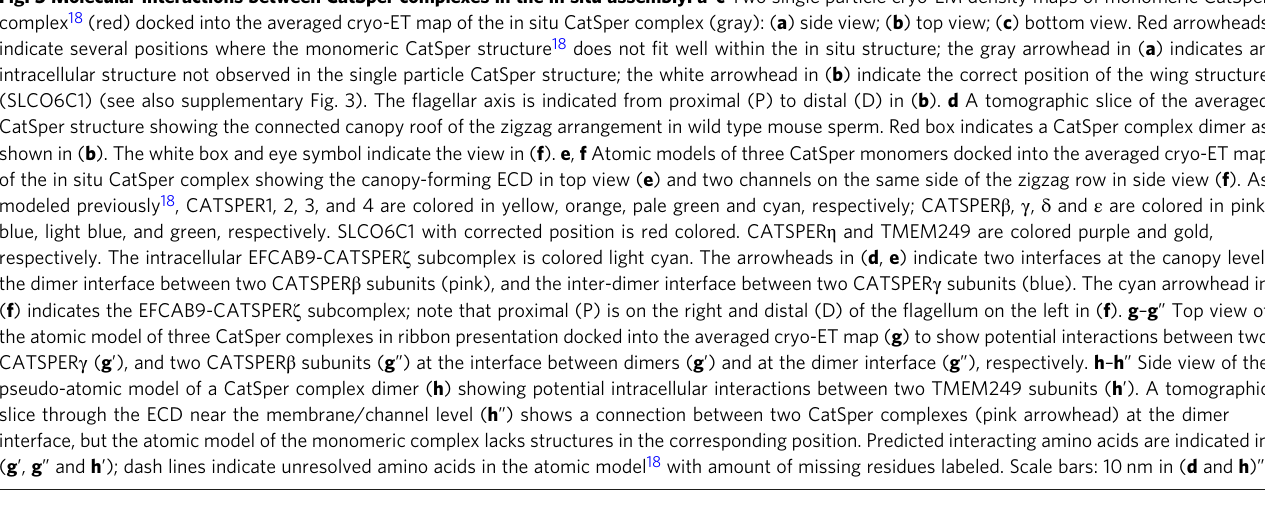
Fig. 5 Molecular interactions between CatSper complexes in the in situ assembly. a – c Two single particle cryo-EM density maps of monomeric CatSper complex 18 (red) docked into the averaged cryo-ET map of the in situ CatSper complex (gray): ( a ) side view; ( b ) top view; ( c ) bottom view. Red arrowheads indicate several positions where the monomeric CatSper structure 18 does not fi t well within the in situ structure; the gray arrowhead in ( a ) indicates an intracellular structure not observed in the single particle CatSper structure; the white arrowhead in ( b ) indicate the correct position of the wing structure (SLCO6C1) (see also supplementary Fig. 3). The fl agellar axis is indicated from proximal (P) to distal (D) in ( b ). d A tomographic slice of the averaged CatSper structure showing the connected canopy roof of the zigzag arrangement in wild type mouse sperm. Red box indicates a CatSper complex dimer as shown in ( b ). The white box and eye symbol indicate the view in ( f ). e , f Atomic models of three CatSper monomers docked into the averaged cryo-ET map of the in situ CatSper complex showing the canopy-forming ECD in top view ( e ) and two channels on the same side of the zigzag row in side view ( f ). As modeled previously 18 , CATSPER1, 2, 3, and 4 are colored in yellow, orange, pale green and cyan, respectively; CATSPER β , γ , δ and ε are colored in pink, blue, light blue, and green, respectively. SLCO6C1 with corrected position is red colored. CATSPER η and TMEM249 are colored purple and gold, respectively. The intracellular EFCAB9-CATSPER ζ subcomplex is colored light cyan. The arrowheads in ( d , e ) indicate two interfaces at the canopy level: the dimer interface between two CATSPER β subunits (pink), and the inter-dimer interface between two CATSPER γ subunits (blue). The cyan arrowhead in ( f ) indicates the EFCAB9-CATSPER ζ subcomplex; note that proximal (P) is on the right and distal (D) of the fl agellum on the left in ( f ). g – g ” Top view of the atomic model of three CatSper complexes in ribbon presentation docked into the averaged cryo-ET map ( g ) to show potential interactions between two CATSPER γ ( g ’ ), and two CATSPER β subunits ( g ” ) at the interface between dimers ( g ’ ) and at the dimer interface ( g ” ), respectively. h – h ” Side view of the pseudo-atomic model of a CatSper complex dimer ( h ) showing potential intracellular interactions between two TMEM249 subunits ( h ’ ). A tomographic slice through the ECD near the membrane/channel level ( h ” ) shows a connection between two CatSper complexes (pink arrowhead) at the dimer interface, but the atomic model of the monomeric complex lacks structures in the corresponding position. Predicted interacting amino acids are indicated in ( g ’ , g ” and h ’ ); dash lines indicate unresolved amino acids in the atomic model 18 with amount of missing residues labeled. Scale bars: 10 nm in ( d and h ) ”